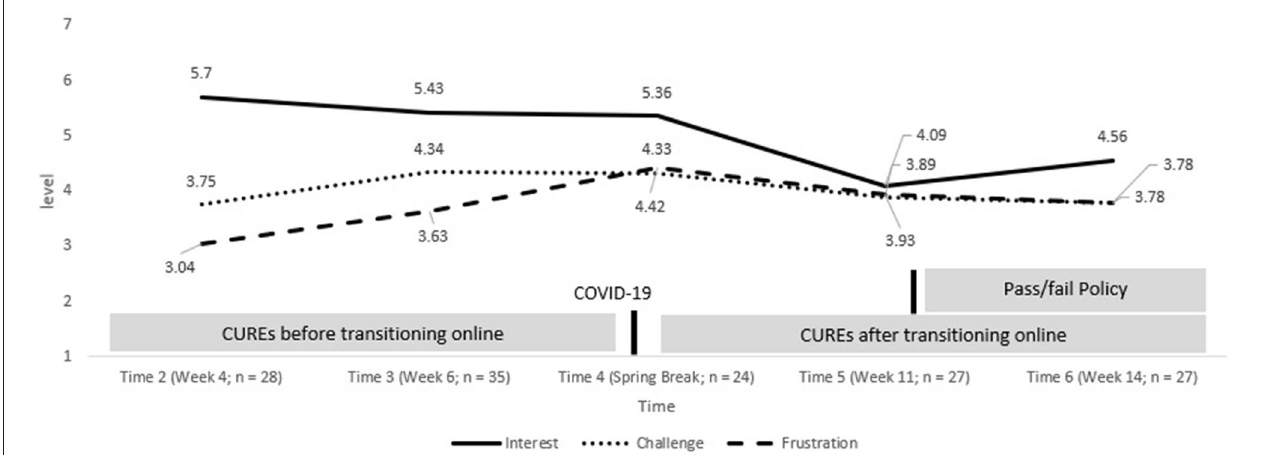
FIGURE 1 | Trends in students’ situational interest, challenge, and frustration over a semester across five time points. The solid line represents the development of situational interest; the dotted line represents the development of situational challenge; and the dashed line represents the development of situational frustration. During Spring 2020, the use of the term “Spring Break” was synonymous with “beginning of COVID-caused course transitions to online instruction.” For the solid line of situational interest, for the students who had completed surveys at Times 2, 3, 5, and 6 ( n = 22), the ANOVA showed significant differences across these four time points [ F (3,63) = 16.24, p < 0.001, η 2 = 0.44]; pairwise comparisons suggested that situational interest after the online transition were lower than before the online transition; no significant difference in situational interest between Times 2 and 3 or between Times 5 and